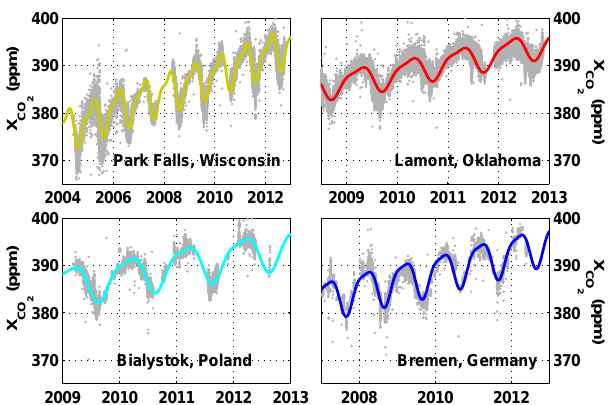
measured at four Northern Hemi- 2